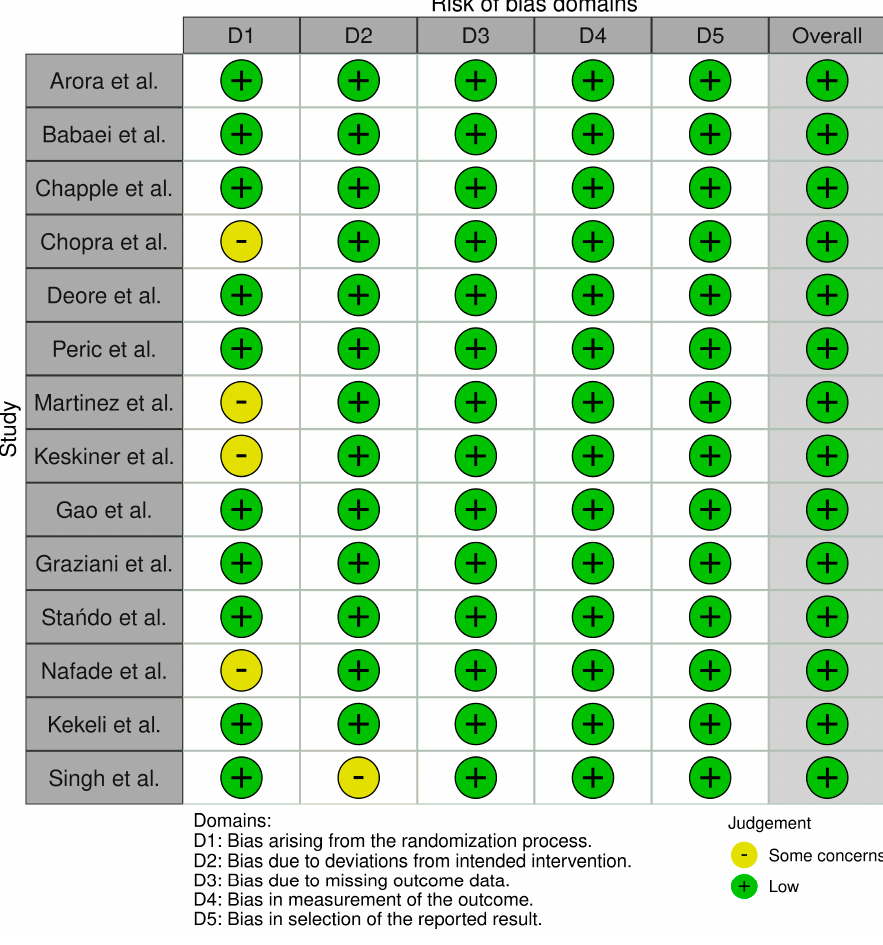
Figure 3. Risk of bias assessment according to RoB2: Overall rating. 3.5. Meta-Analysis and Grading of Evidence Due to a limited data availability, regarding the within-groups di ff erences, no useful meta-analysis or grading (GRADE) was possible. Of the 14 included studies, only 5 studies reported within-group di ff erences on some clinical parameters on di ff erent nutraceuticals [26,34,37–39]. All corresponding authors from studies investigating the same nutraceuti- cal (omega-3 fa tt y acids, vitamin D, green/oolong tea) were contacted via email. Only one corresponding author answered, but they were not able to deliver the needed within- group di ff erences. However, a preliminary meta-analysis was performed for all investigated nutraceu- tical approaches with a data report for the di ff erences between baseline and 3 months follow-up. In total, four studies could be included for PPD and CAL [26,34,37,38]. Due to a lack of BOP data, the study of Chopra et al. [38] could not be included into the meta- analysis for BOP. Moreover, Singh et al. [39] reported the median values with minimum